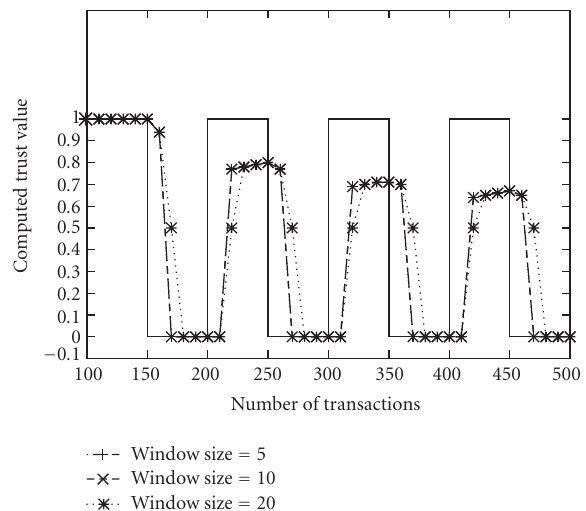
Figure 5: E ff ectiveness of our decoupled trust model against oscil- lating peer